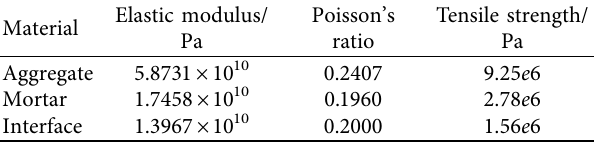
Table 1: Material parameters.